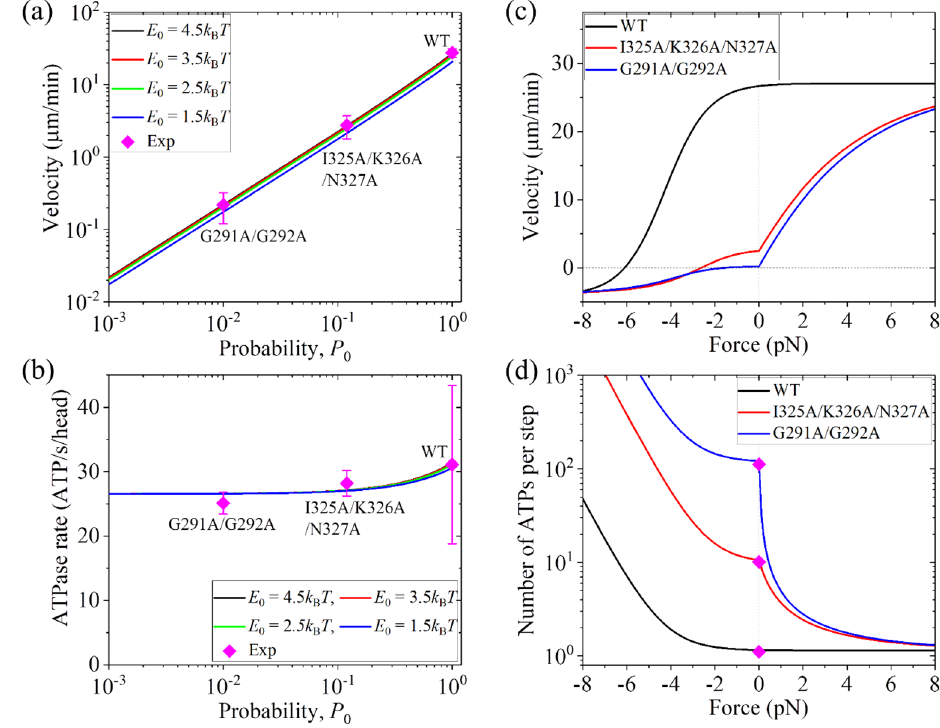
Figure 4. Dynamics of human kinesin-1 motors. WT, I325A/K326A/N327A, and G291A/G292A represent the wild type K560, the mutant K560-I325A/K326A/N327A with Ile325, Lys326, and Asn327 in NL being changed to alanine and the mutant K560-G291A/G292A with Gly291 and Gly292 in loop 13 of the catalytic core being changed to alanine, respectively. Lines are theoretical results. Symbols are experimental data taken from Case et al. [38]. ( a ) Velocity versus probability P 0 under no load for different values of E 0 . Note that the red line is almost coincident with the black line and thus the red line cannot be discerned. ( b ) ATPase rate per head versus probability P 0 under no load for different values of E 0 . Note that the red line is almost coincident with the black line and thus the red line cannot be discerned. ( c ) Velocity versus backward and forward loads. Data for the WT, I325A/K326A/N327A, and G291A/G292A are calculated with E 0 listed in Table 2 being subtracted by E NL = 0, 2 k B T , and 1 k B T , respectively. ( d ) Number of ATPs consumer per step versus backward and forward loads. Data for the WT, I325A/K326A/N327A, and G291A/G292A are calculated with E 0 listed in Table 2 being subtracted by E NL = 0, 2 k B T , and 1 k B T , respectively. The experimental data are calculated with N = 2 k cat d / v ( d = 8.2 nm), where k cat is the ATPase rate per head and v is the velocity measured by Case et al.